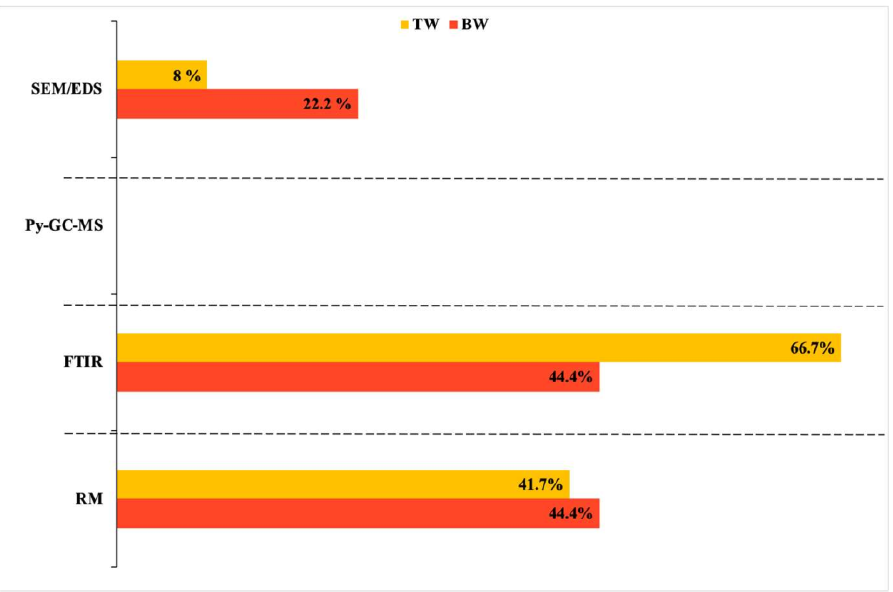
Figure 4. Validated analytical procedures and percentage of application in DW studies. RM: Ra- man Spectroscopy; SEM/EDS: Scanning Electron Microscopy/Energy Dispersive X-ray spectrome- try; FTIR: Fourier—Transform Infra-red spectroscopy; Py-GC-MS: Pyrolysis Gas Chromatography Mass